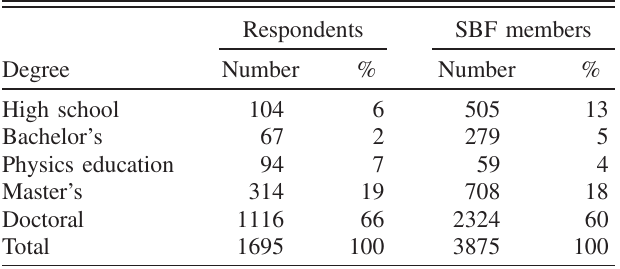
TABLE I. Composition of respondents according to academic degree, compared to the composition of SBFaffiliates. (Bachelor ’ s and physics education are undergraduate degrees at the same level of education.)